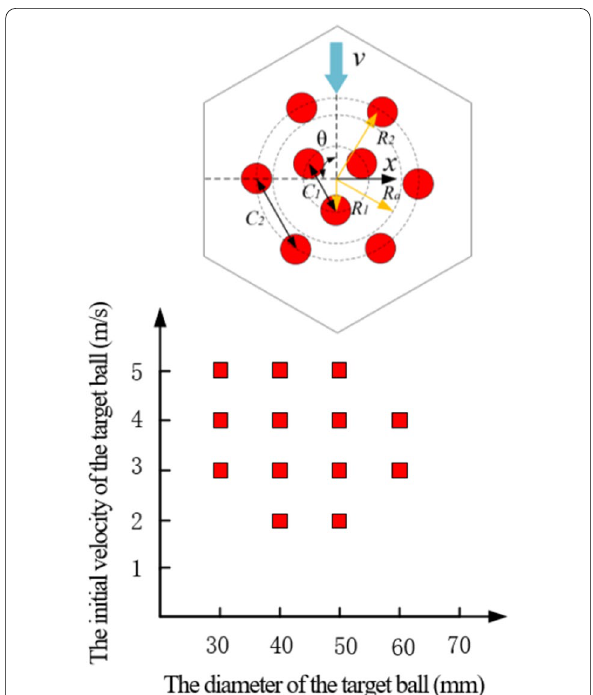
Figure 8 Arms are arranged in two circles where R 1 = 20mm , R 2 = 50 mm , R a = 40mm , C 1 = 34.64 mm , C 2 =